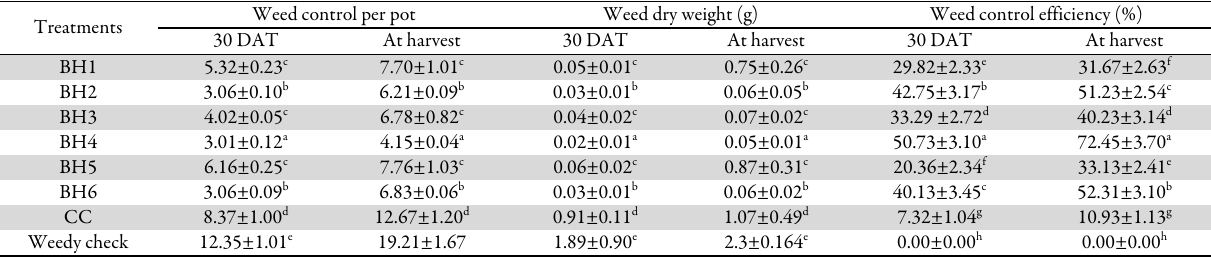
Table 3. The weed parameters of maize plant after application of various treatments Weed control per pot Weed dry weight (g) Weed control efficiency Treatments